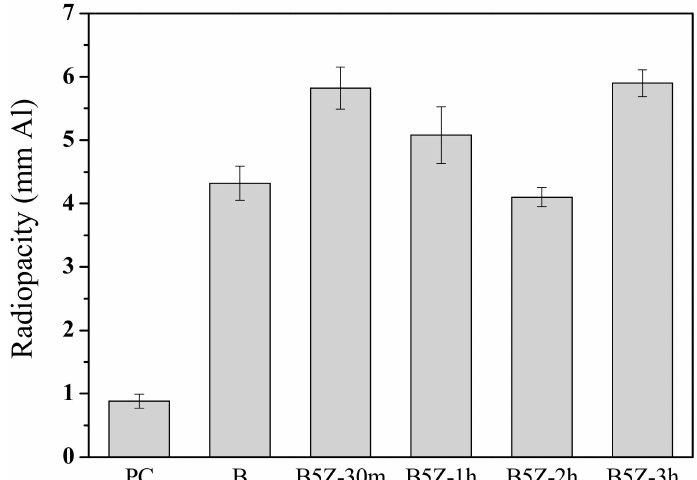
Figure 3. Radiopacities of MTA-like cements prepared by 5% zirconia-added bismuth oxide powder after milling for 30 min, 1 h, 2 h, and 3 h (coded as B5Z-30m, etc.) In addition, Portland cement (sample PC) and MTA with bismuth oxide (sample B) were given as